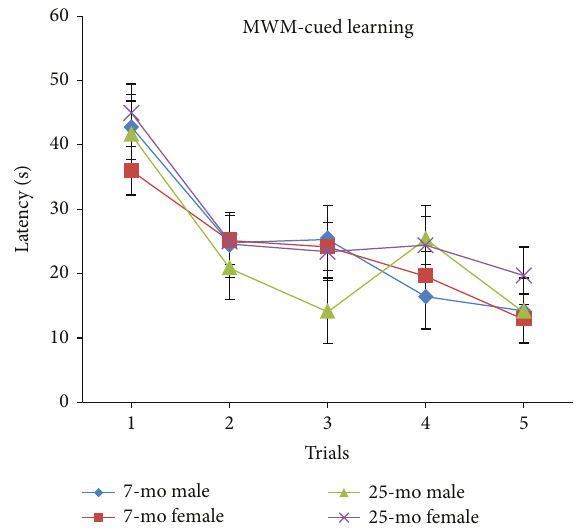
Figure 4: Number of errors of 7- and 25-month-old C57BL/6 mice in learning phase of RAWM (mean ± SEM). ∗∗∗ P < 0 001 .